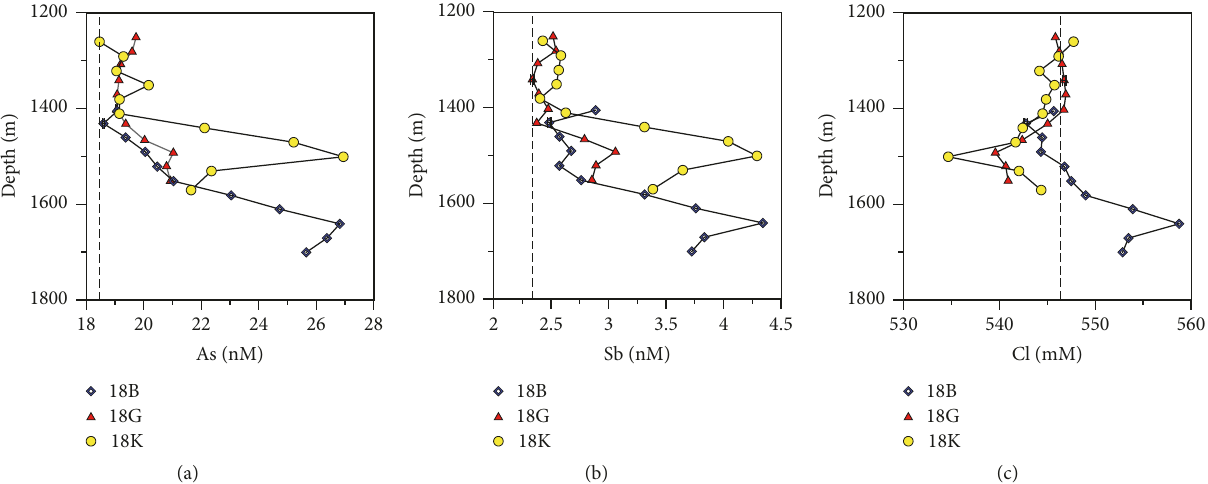
Figure 3: Vertical profiles of As (a), Sb (b), and Cl (c) at Stations 18B, 18G, and 18K. The dashed line represents the As (18.4nM), Sb (2.33 nM), and Cl (546 mM) value of ambient